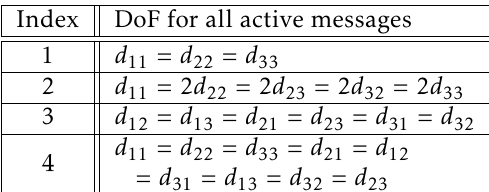
Table 2. Examples of the source and destination DoF conditions for single-antenna node and | V